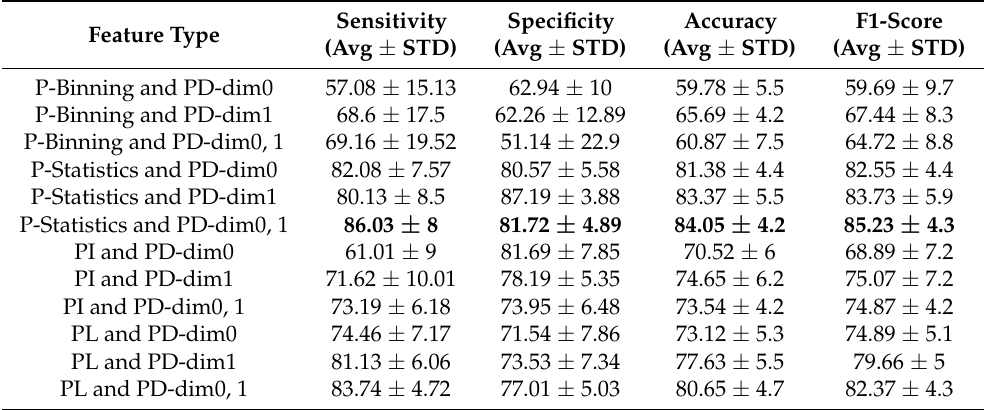
Table 5. Cubical complex performance results for the DDSM dataset using four different vectorization methods and three homology